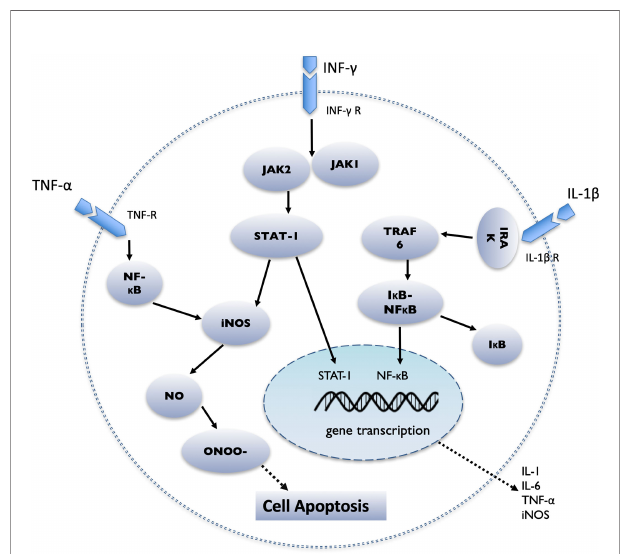
FIGURE 1 | Schematic diagram demonstrating the intracellular cascade of events that occur in the pancreatic islet after stimulation by IL-1 b , IFN- g and TNF- a . IL-1 b binds to the IL-1 b receptor (IL-1 b R), causing TNF receptor- related factor 6 (TRAF6) to be activated by IL-1 receptor-related kinase (IRAK), then NF- k B is released from inhibitory I k B, transferred from the cytoplasm to the nucleus, and regulates the transcription of various genes, including IL-1, IL-6, TNF- a , and iNOS; TNF- a binding to the TNF receptor (TNF-R), initiates the activation of NF- k B and the induction of apoptosis; IFN- g binds to the IFN- g receptor (IFN- g R) and causes the activation of JAK1 and JAK2. JAK2 then activates signal transducers and activators of transcription 1 (STAT1), which then transfers to the nucleus, where it performs gene